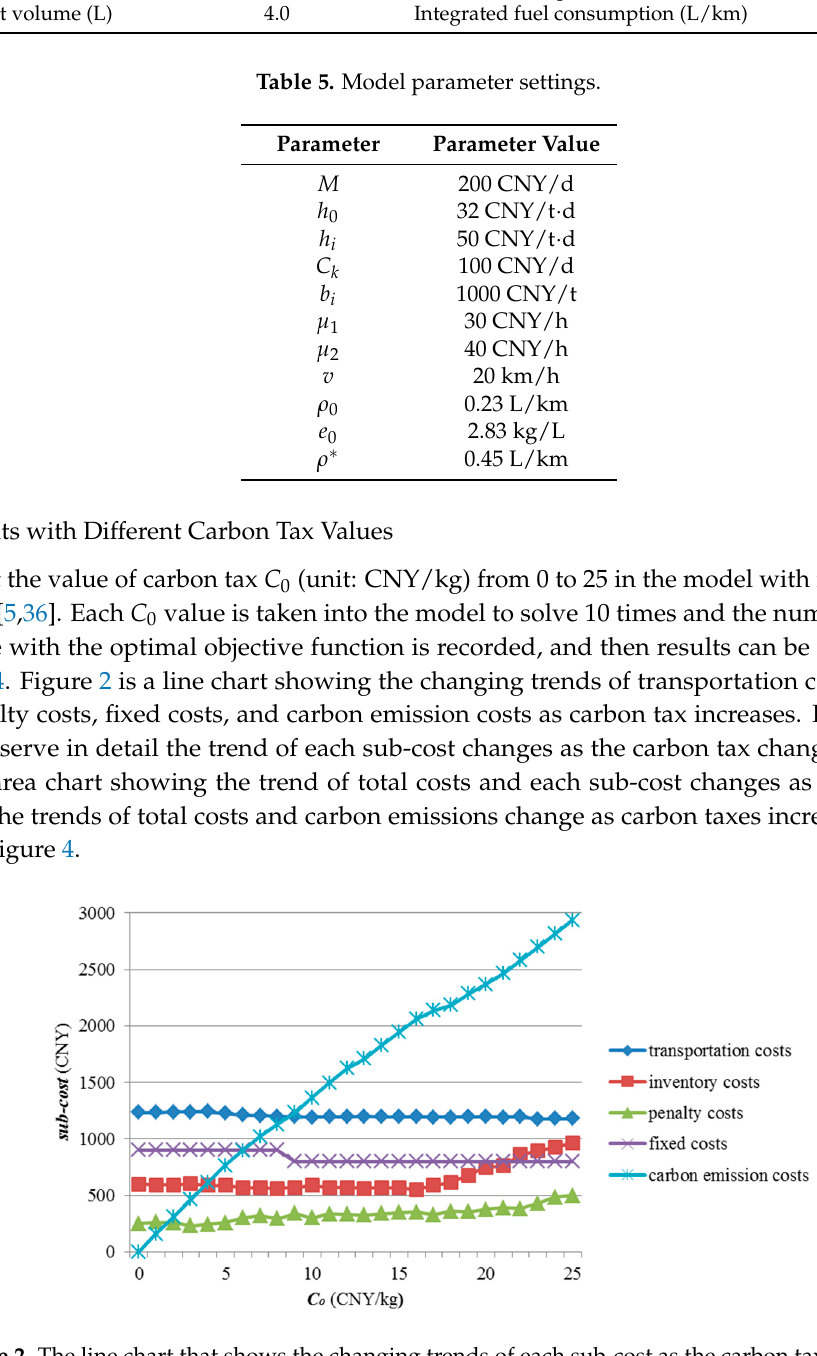
Figure 2. The line chart that shows the changing trends of each sub-cost as the carbon tax changes.